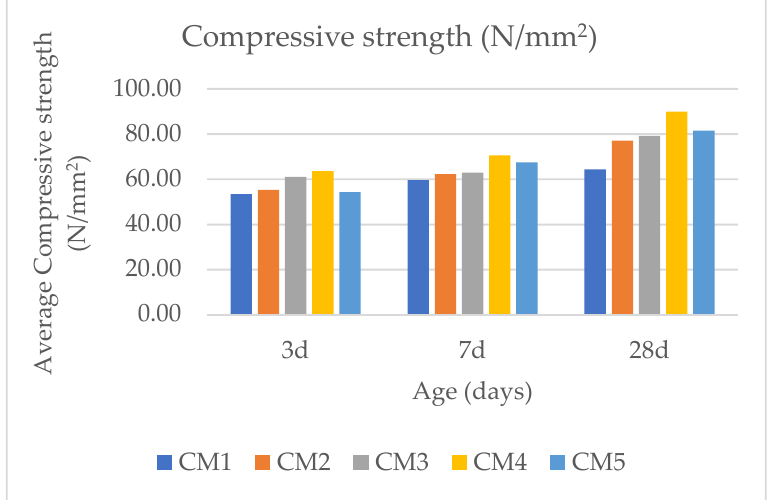
Figure 6. Compressive strength of CM-UFS-GO.